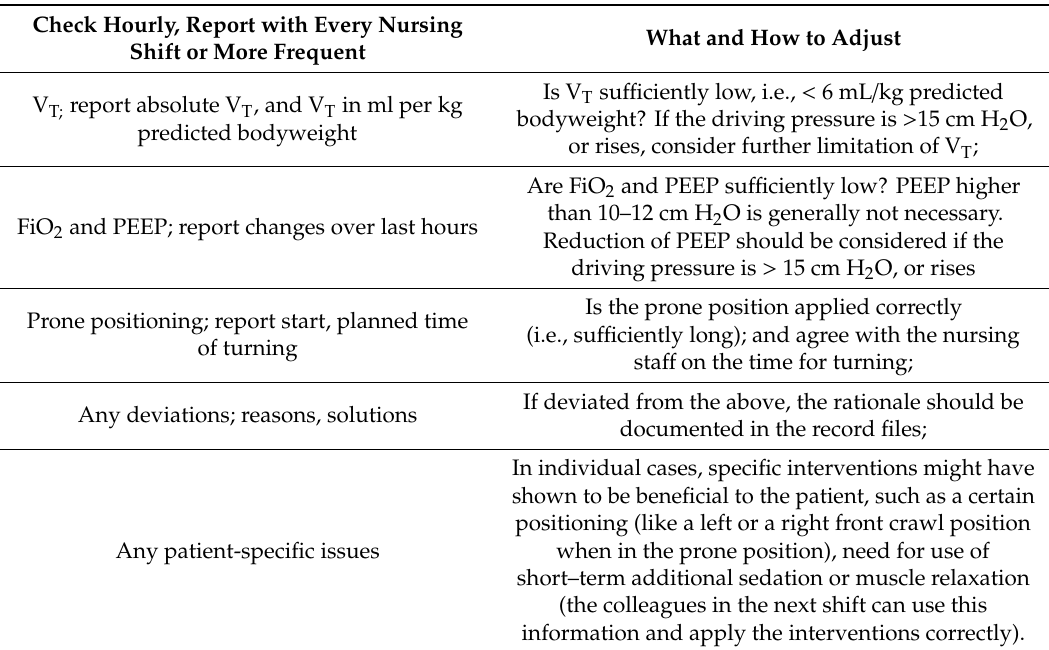
Table 2. A useful checklist performed during nursing